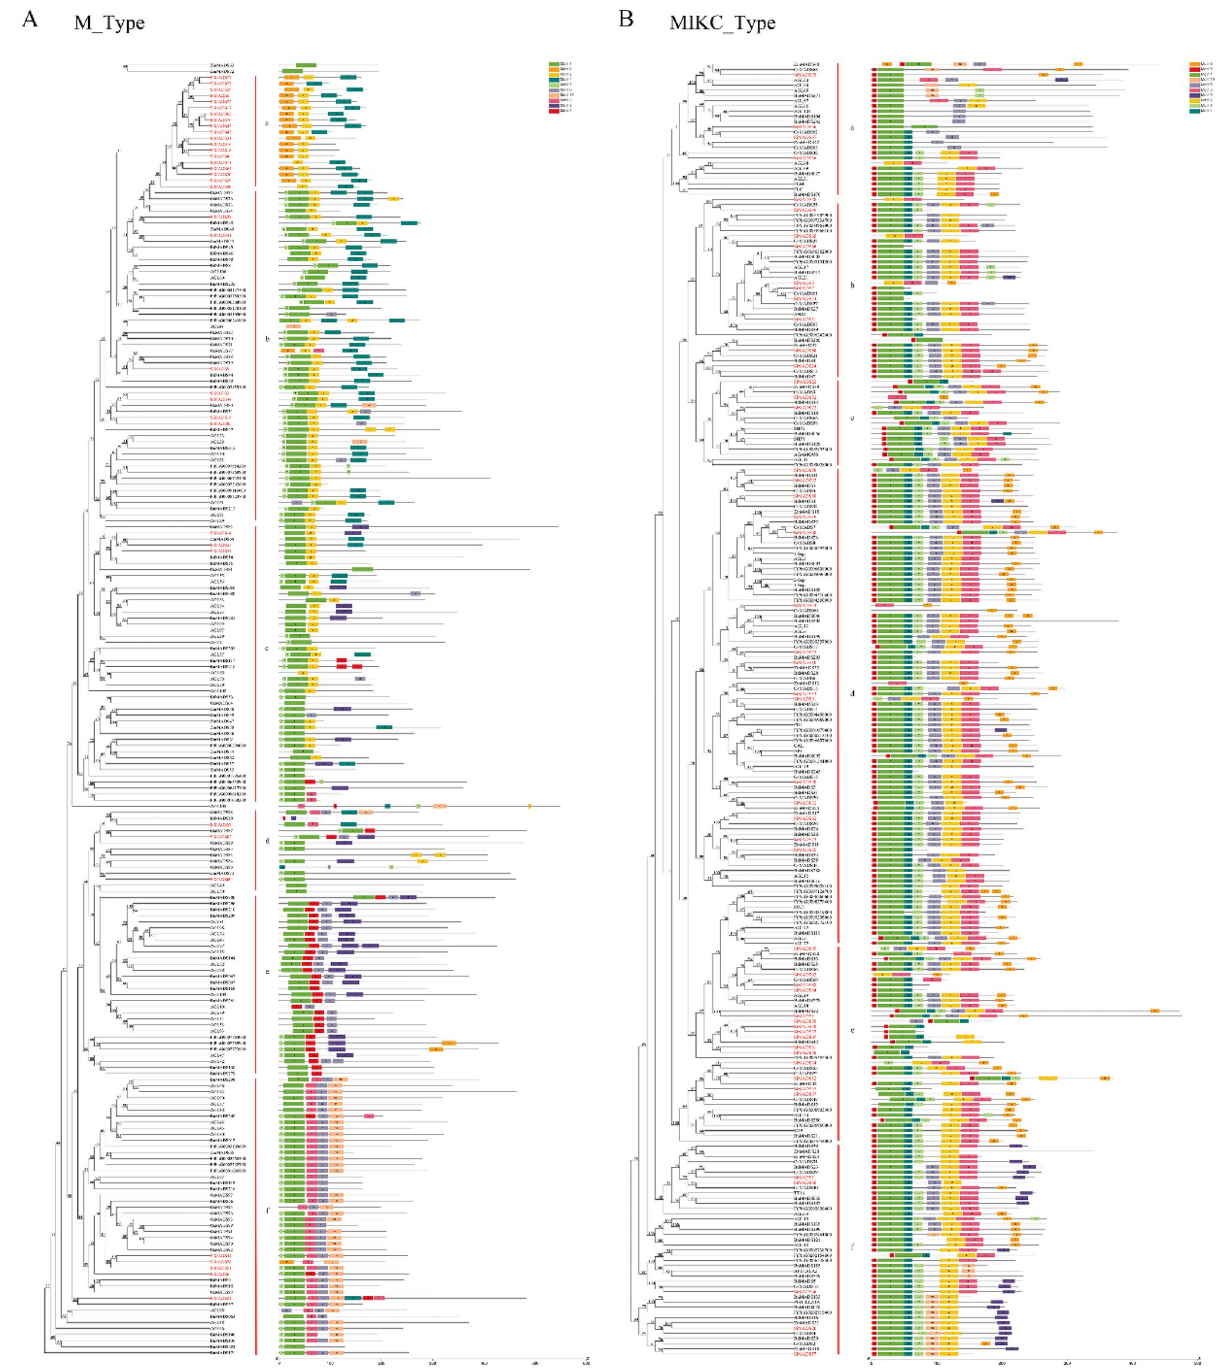
Figure 6. Phylogenetic relationship and motif composition of MADS-box proteins from S. italica with six different plant species ( A. thaliana , F. tataricum , B. napus , B. distachyon , O. sativa , Z. mays ). ( A ) Evolutionary relationship between M-type MADS-box proteins and motif composition. ( B ) Evolutionary relationship between MIKC-type MADS-box proteins and motif composition. Different-colored boxes represent different motifs and their positions in each MADS-box protein sequence. Sequence information for each motif is provided in Table